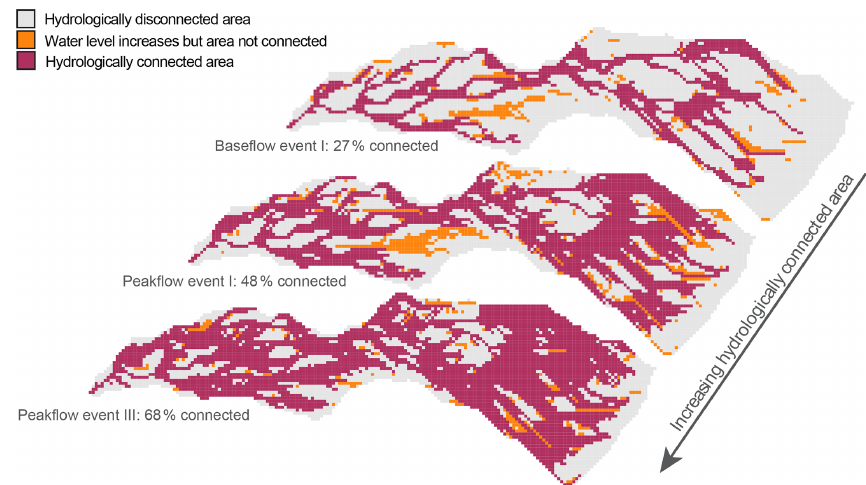
Figure 4. The simulated hydrologically connected area for three different flow conditions: from relatively low flow (baseflow prior to event I; top) and intermediate flow conditions (peak flow during event I; middle) to the period of highest discharge for the studied events (peak flow during event III; bottom). Grey indicates the hydrologically disconnected areas (water level more than 30cm from the soil surface), red indicates the hydrologically connected area (i.e. water level within 30cm from the soil surface and connected to the stream via other active areas), and orange indicates the active but disconnected area (i.e. the water level increased into the upper 30cm of the soil but is not connected to the stream network by other active areas). The connected area was simulated based on the measured groundwater levels and a data-driven model that uses surface topography to estimate the water level for unmonitored grid cells (cf. Rinderer et al.,